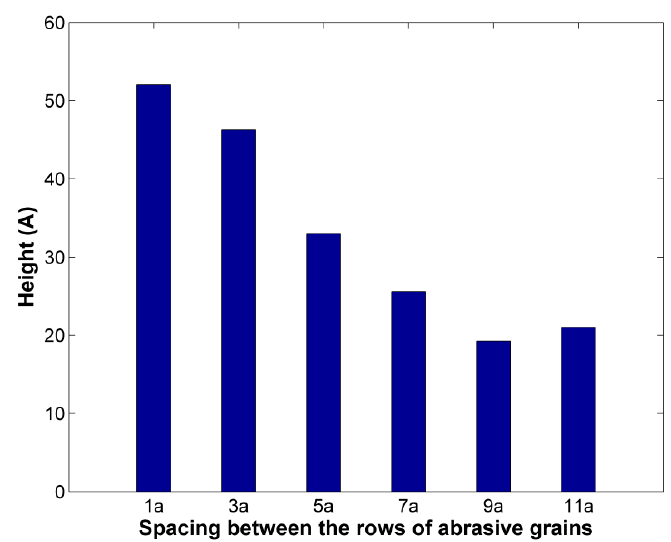
Figure 4. Height of chip in cases with different spacing between the rows of abrasive grains.